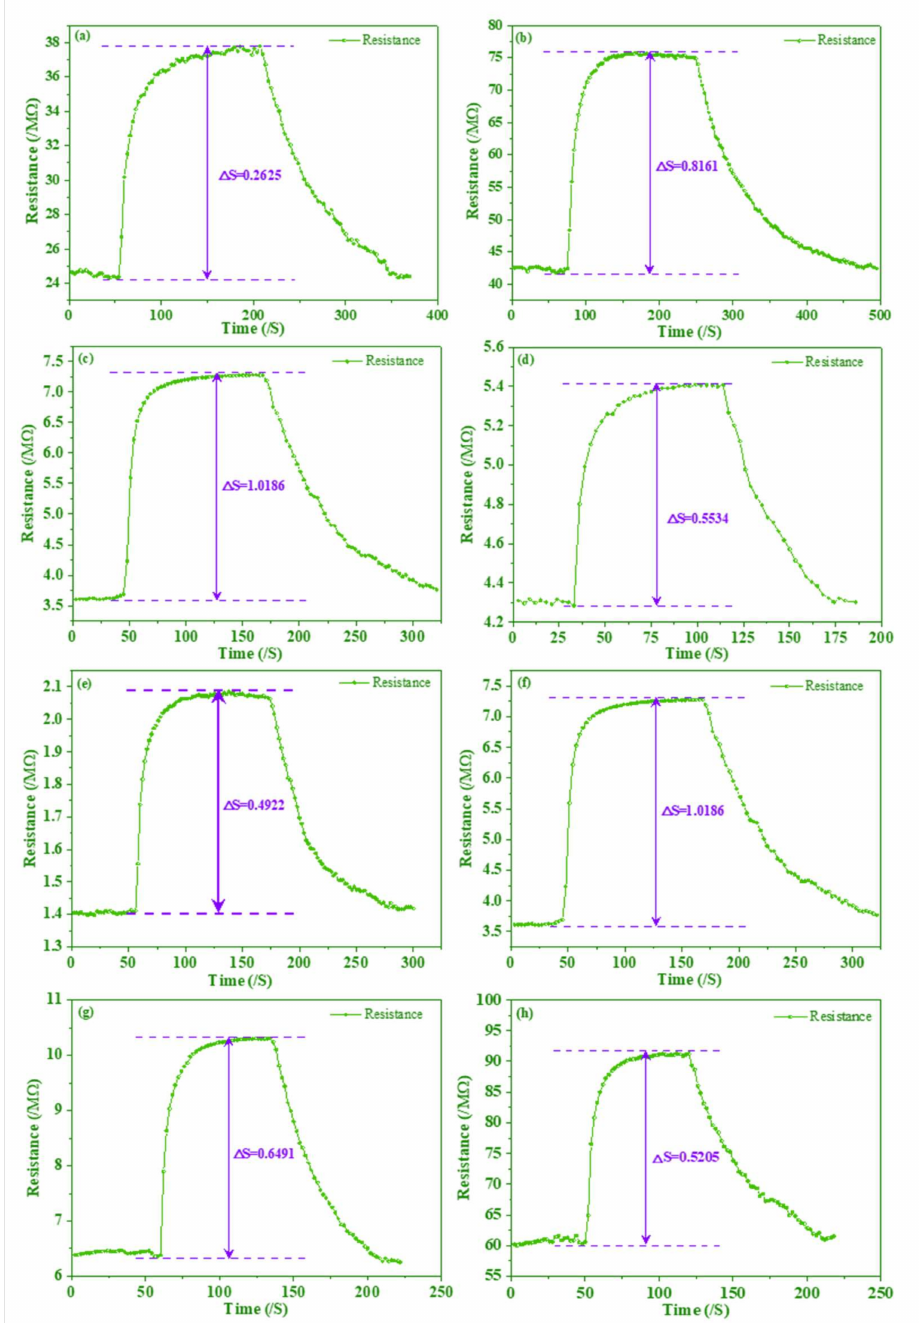
Figure 3. The response and recovery curves of the sensor towards 100 µ g/L TMA with different volumes of AgNWs in ( a – d ) and different times in ( e – h ). Figure 4b displayed the Raman spectra of the different composites. The spectra of PANI/AgNWs/silk and PANI/silk composites exhibited a peak at 1490 cm − 1 (stretching vibrations of C=N belonging to quinonoid units) and a band at 1585 cm − 1 (stretching vibration of C=C in the quinonoid ring) [36]. Compared with PANI, the peaks for stretching vibrations of C=C and C=N belonging to quinonoid units moved to higher wavenumbers in PANI/silk and PANI/AgNWs/silk. The phase shift of spectra indicated the interaction of polymers with peptide bonds existing in SFFs macromolecule. The peak at 1166 cm − 1 belongs to bending vibrations of C − N in semi-quinonoid rings [37]. On the other hand, the band of PANI/AgNWs/silk had a shoulder peak at 1159 cm − 1 for bending